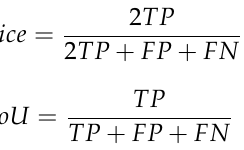
Figure 9. A training segmentation map or label .